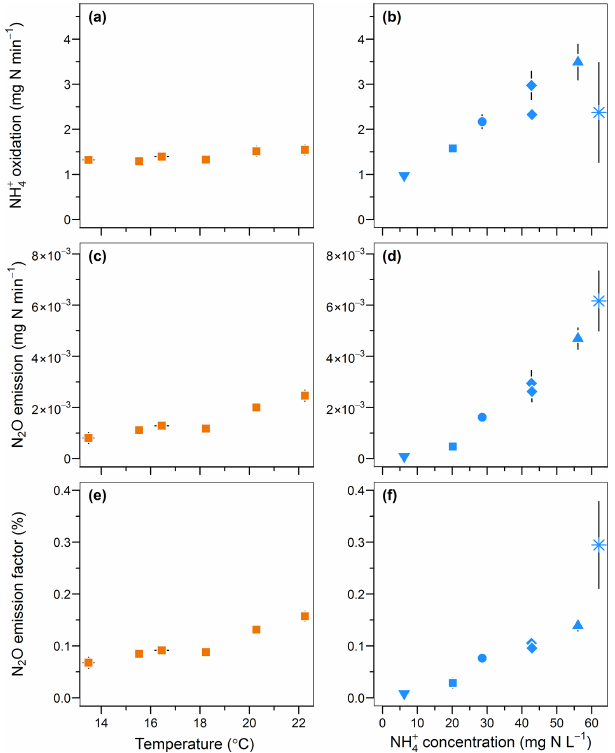
Figure 5. Effect of temperature and inflow ammonium concentra- tion on (a, b) the ammonium oxidation rate, (c, d) the nitrous oxide emission rate and (e, f) the N 2 O emission